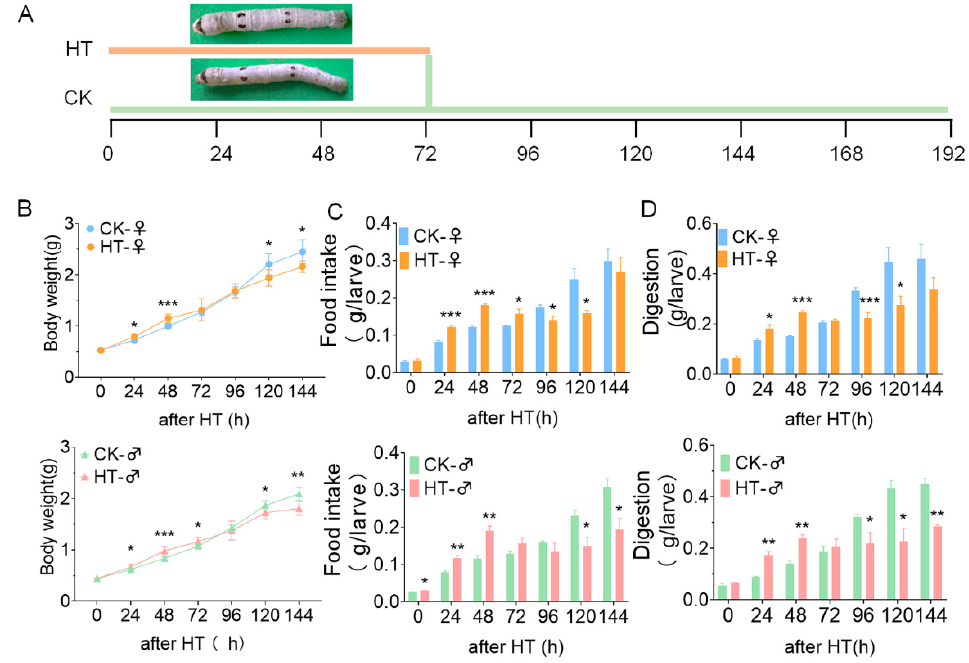
Figure 1. The effect of high temperature on the growth and development of silkworm. ( A ) Time axis of high-temperature treatment. ( B ) The weight survey of silkworm, n ≥ 7. ( C ) Food intake capacity of the larvae (grams per larva). ( D ) Digestion capacity of the larvae (grams per larva). *, p ≤ 0.05; **, p ≤ 0.01; ***, p ≤ 0.001. CK, control group; after HT, high-temperature treatment.